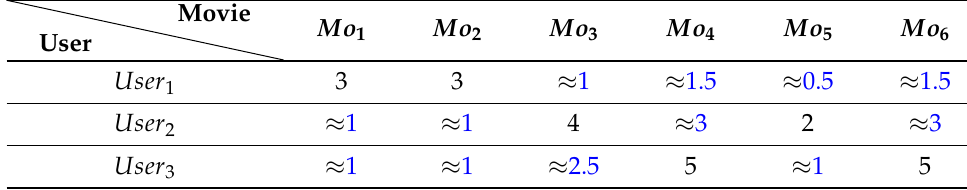
Table 12. User-Movie rating dataset.